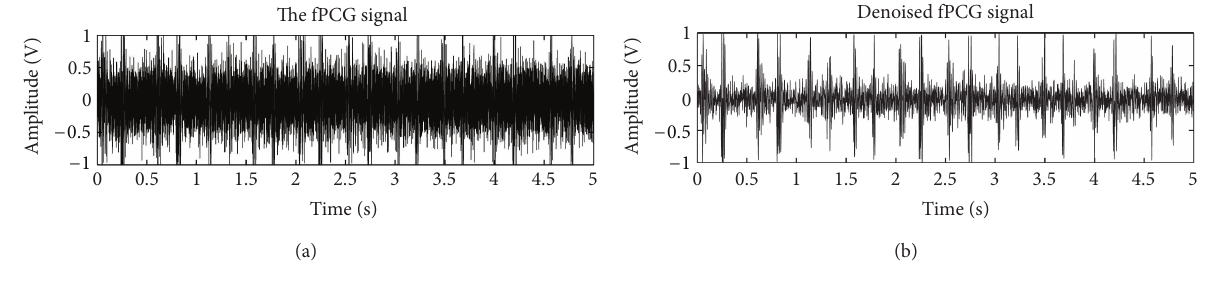
Figure 9: Waveforms of a real fPCG signal and its denoised version. Table 2: Comparison of different mother wavelets for denoising of fPCG signals in terms of